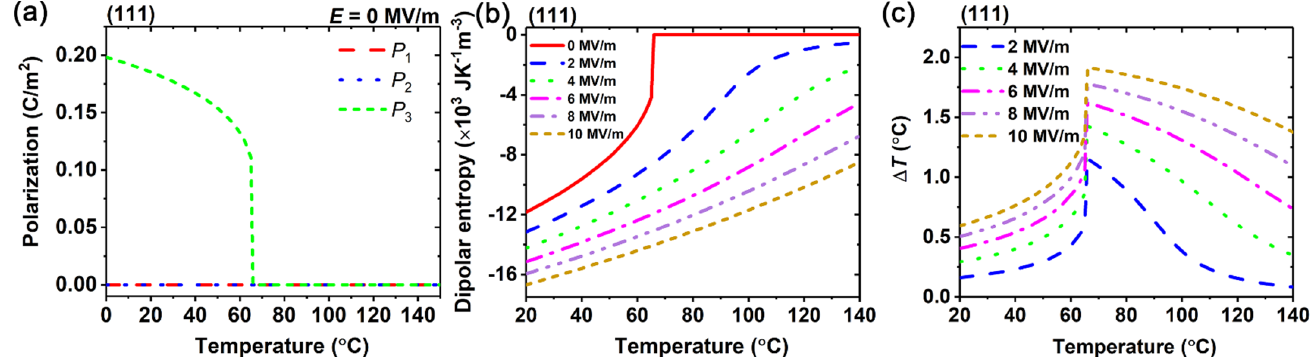
Figure 3. ( a ) Polarizations of (111)-oriented BaZr 0.15 Ti 0.85 O 3 in the absence of external electric field. ( b ) Dipolar entropy and ( c ) adiabatic temperature change Δ T under different electric fields as a function of temperature.